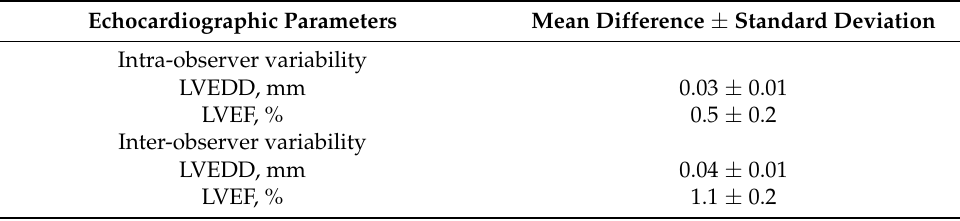
Table 2. Intra- and inter-observer variabilities of the echocardiographic parameters.